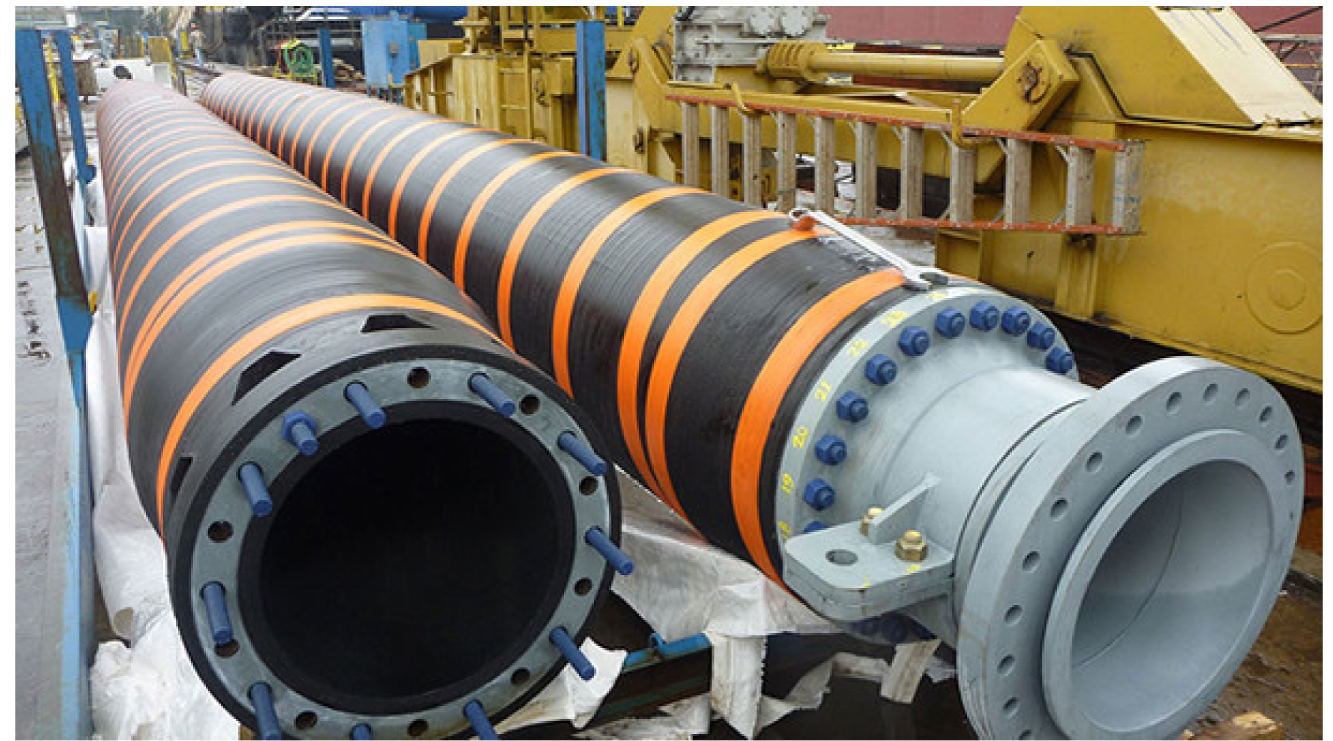
Figure 1. Image of marine hoses on a rack. (Courtesy: Trelleborg; adapted with